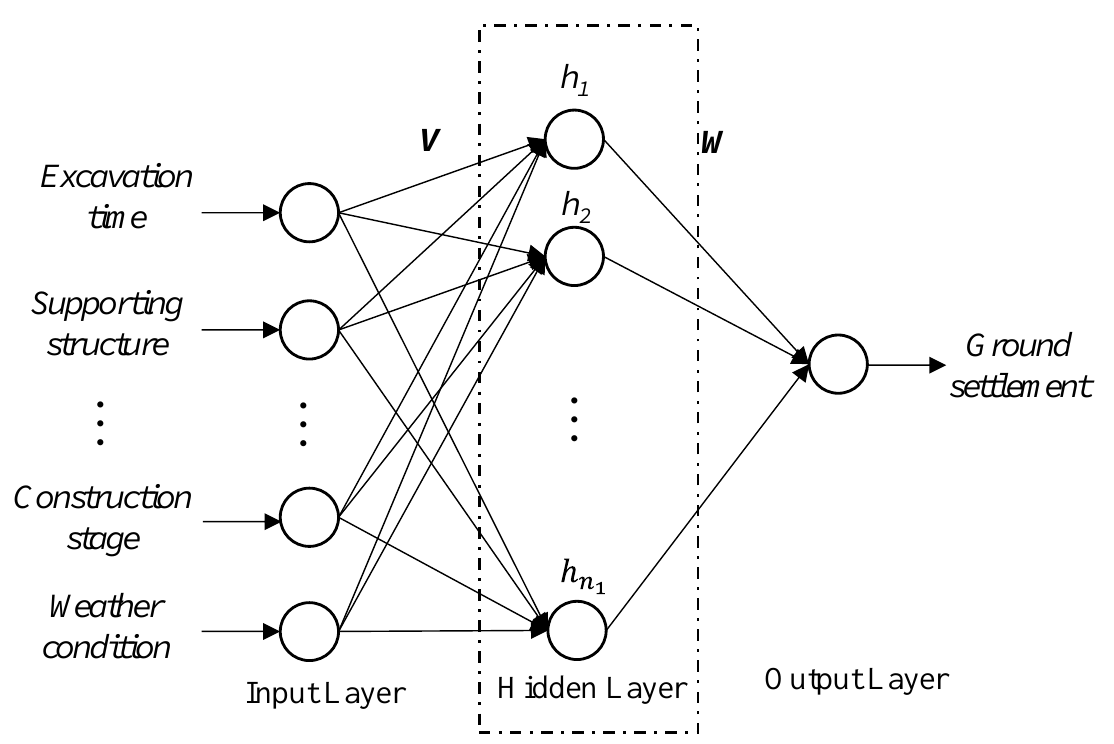
Figure 2. A specific BPNN for the proposed study.